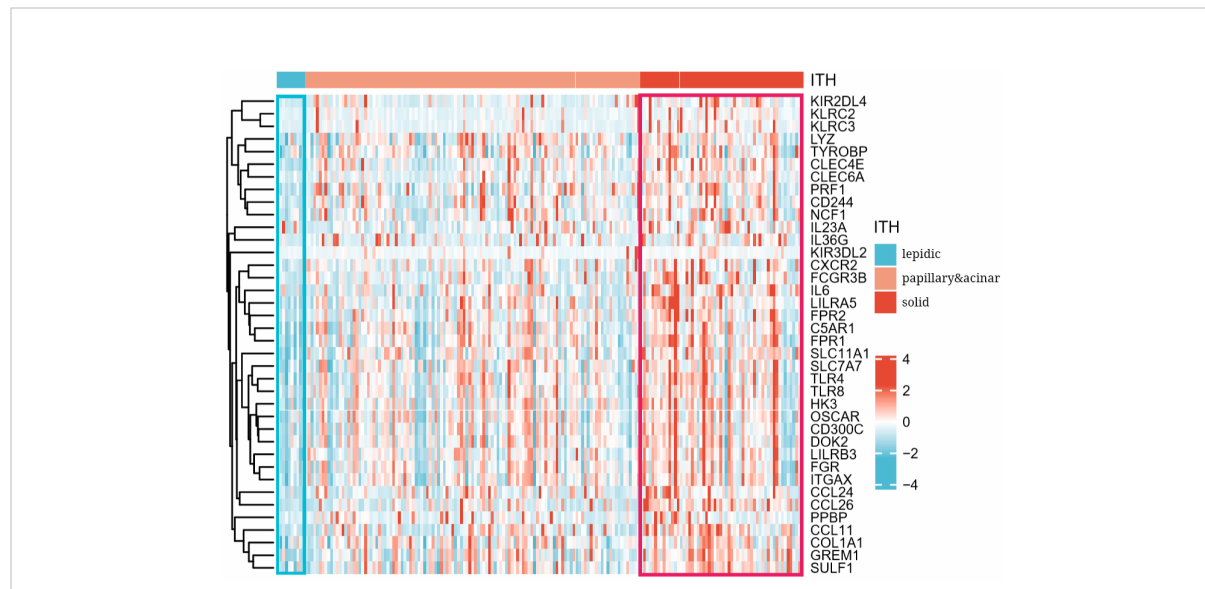
FIGURE 3 Heatmap of transcriptional patterns re fl ected histologic progression from lepidic to solid subtype.